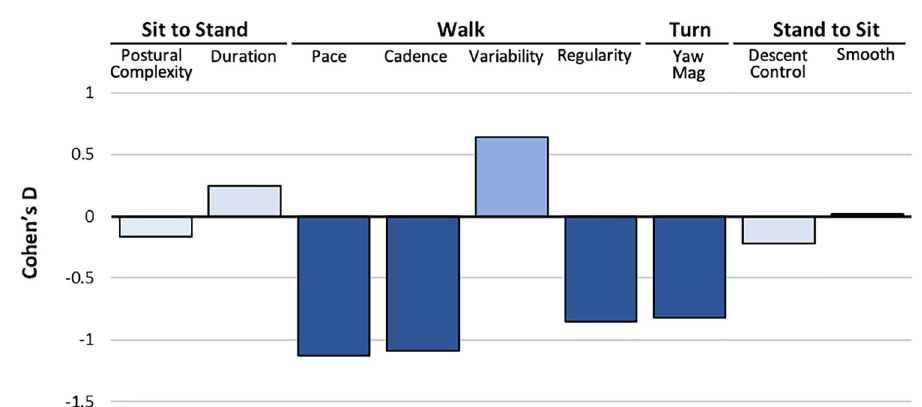
Fig 4. Dual-task cost effect sizes during the four TUG subtasks. Small effects of divided attention testing (Cohen’s d < 0.5; light blue) were observed in the control and duration of the sit-to-stand transition. Medium ( > 0.5) to large effects ( > 0.8; dark blue) were observed in the walking and turn procedures. A small effect was observed during the stand-to-sit transition only for postural descent control.